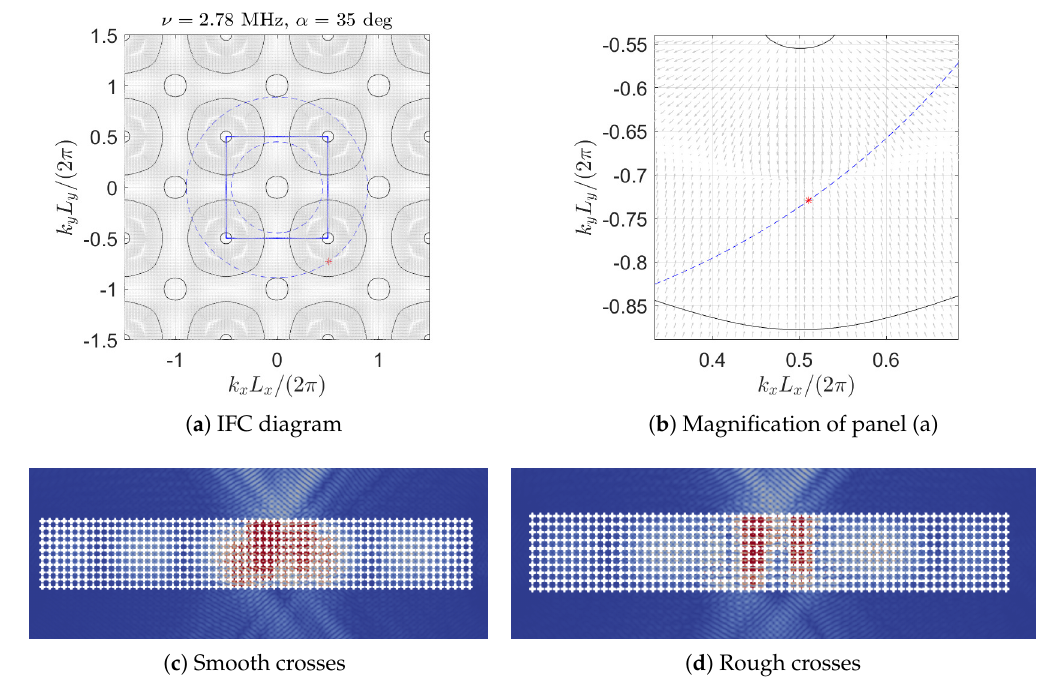
Figure 8. Effect of roughness on the scattering of a Gaussian beam with α = 35 ◦ and f = 2.78 MHz. The roughness is defined by δ = 5 µ m and λ 0 = 5 µ m. Panels ( a , b ) show the IFC diagram (and its magnification) for smooth crosses. Panels ( c , d ) show simulation snapshots for the smooth and rough cases at the same time, t = 93 µ s, with the total time being T = 120 µ